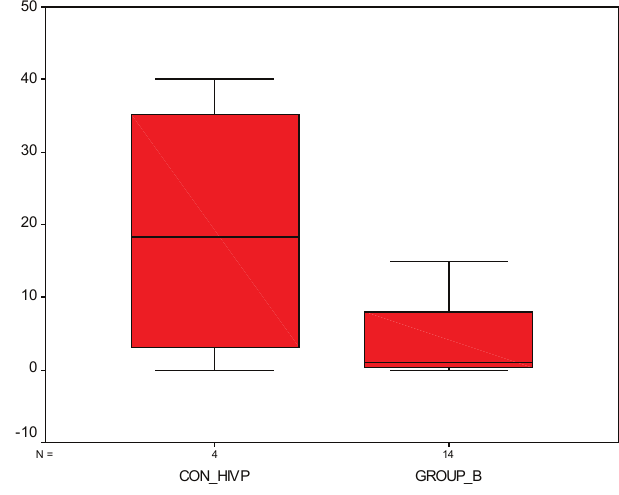
FIGURE 3 – Boxplot – Comparison of Langerhans cell populations between HIV-positive control group and Group B